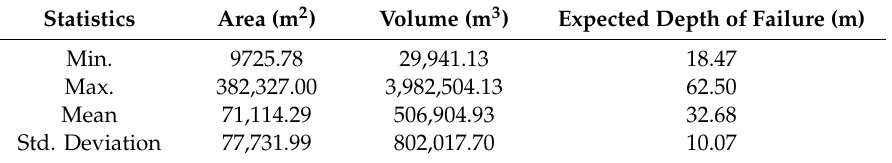
Table 1. Descriptive statistics of the landslide area, volume, and expected depth of failures.